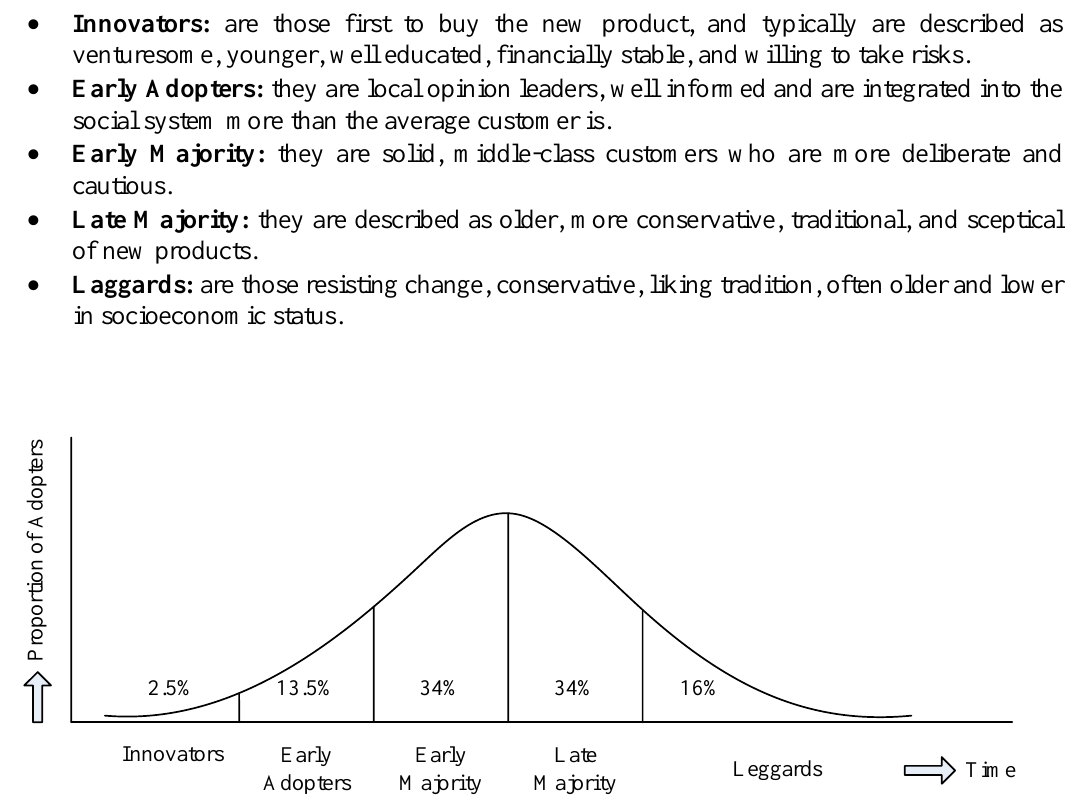
Figure 3. Adoption categorization based on the Relative Time of Adoption of Innovations [Source: Rogers,